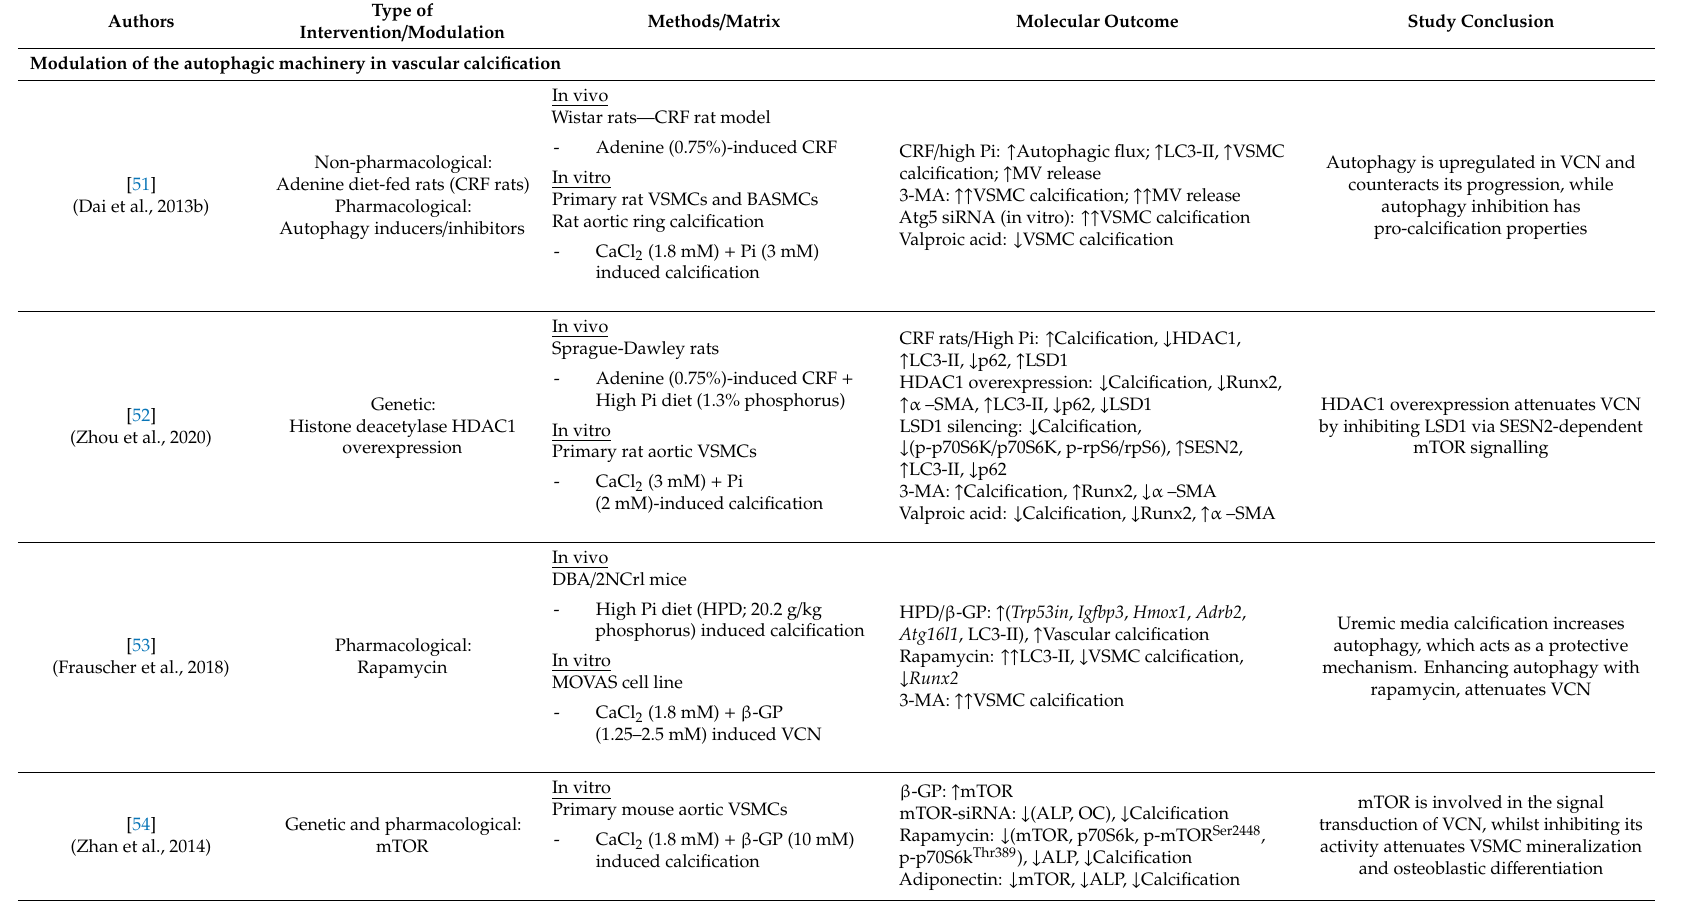
Table 1. Studies on the modulation of autophagy and lysosomal function in vascular